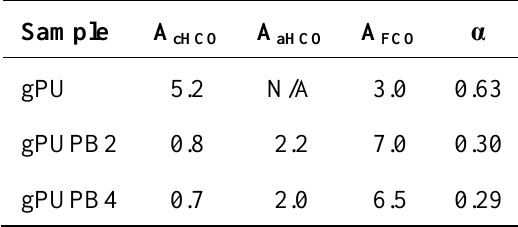
Table 4. Hydrogen bonding index ( α ) of SMPU with amorphous soft